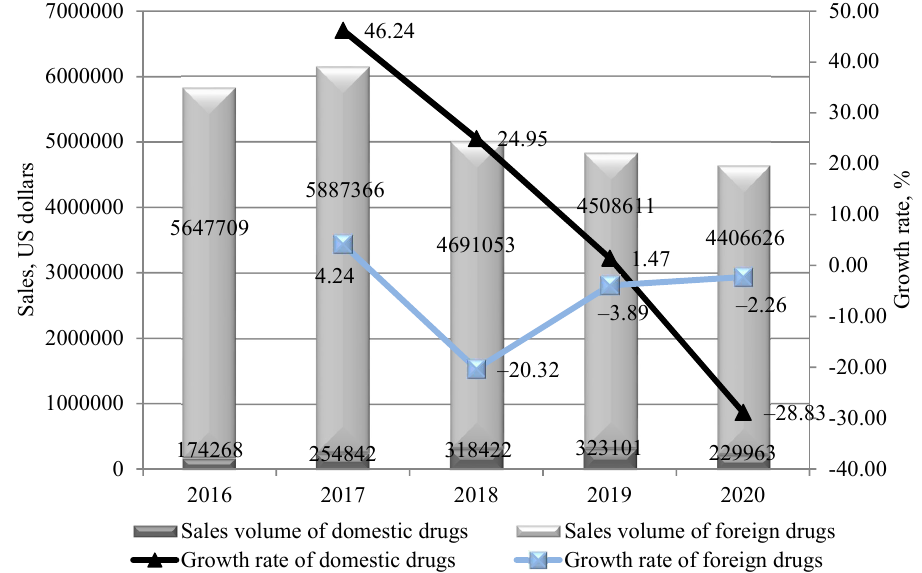
Fig. 4. Dynamics of indicators of retail sales of antiepileptics in cash for the pharmaceutical market of Kazakhstan